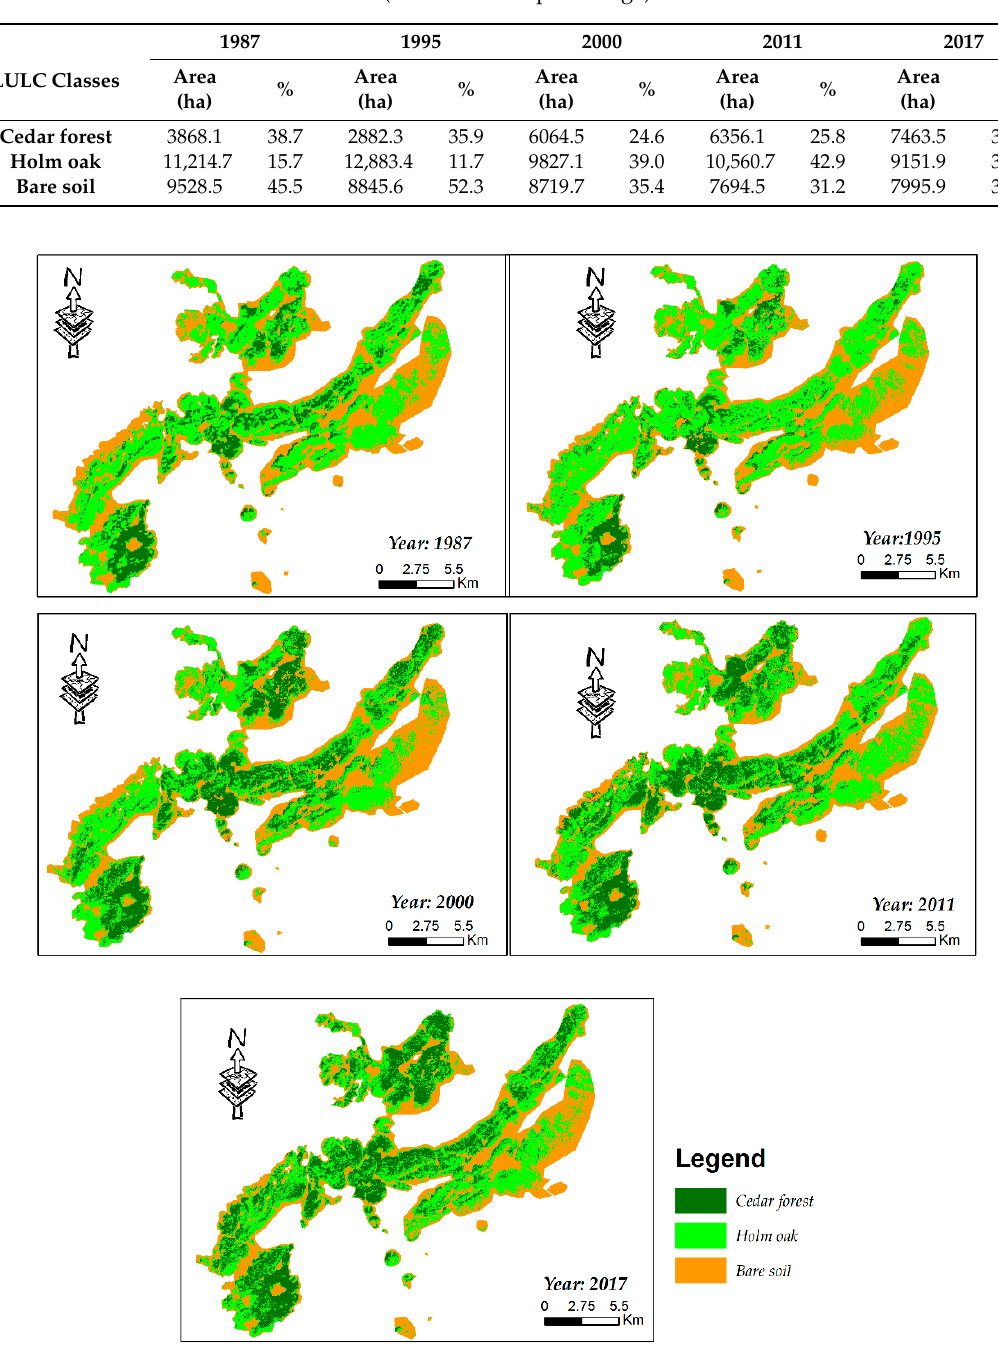
Figure 3. Land use/land cover (LULC) maps